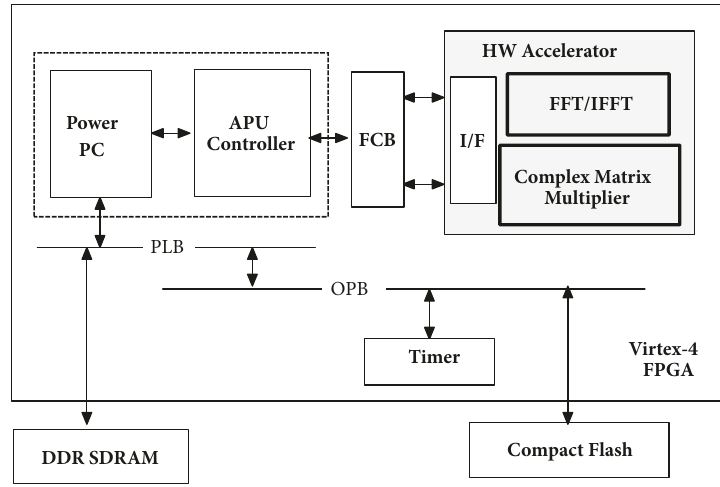
Figure 3: Block diagram of the proposed FPGA architecture for BSS.